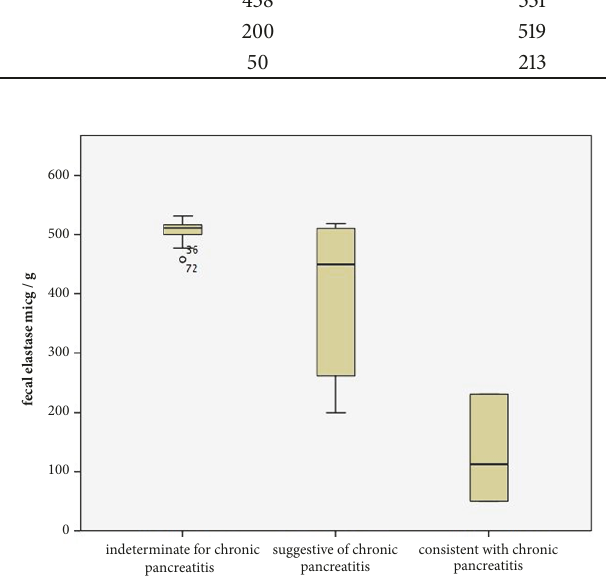
Figure 1: Boxplot of fecal elastase levels grouped according to the EUS Rosemont